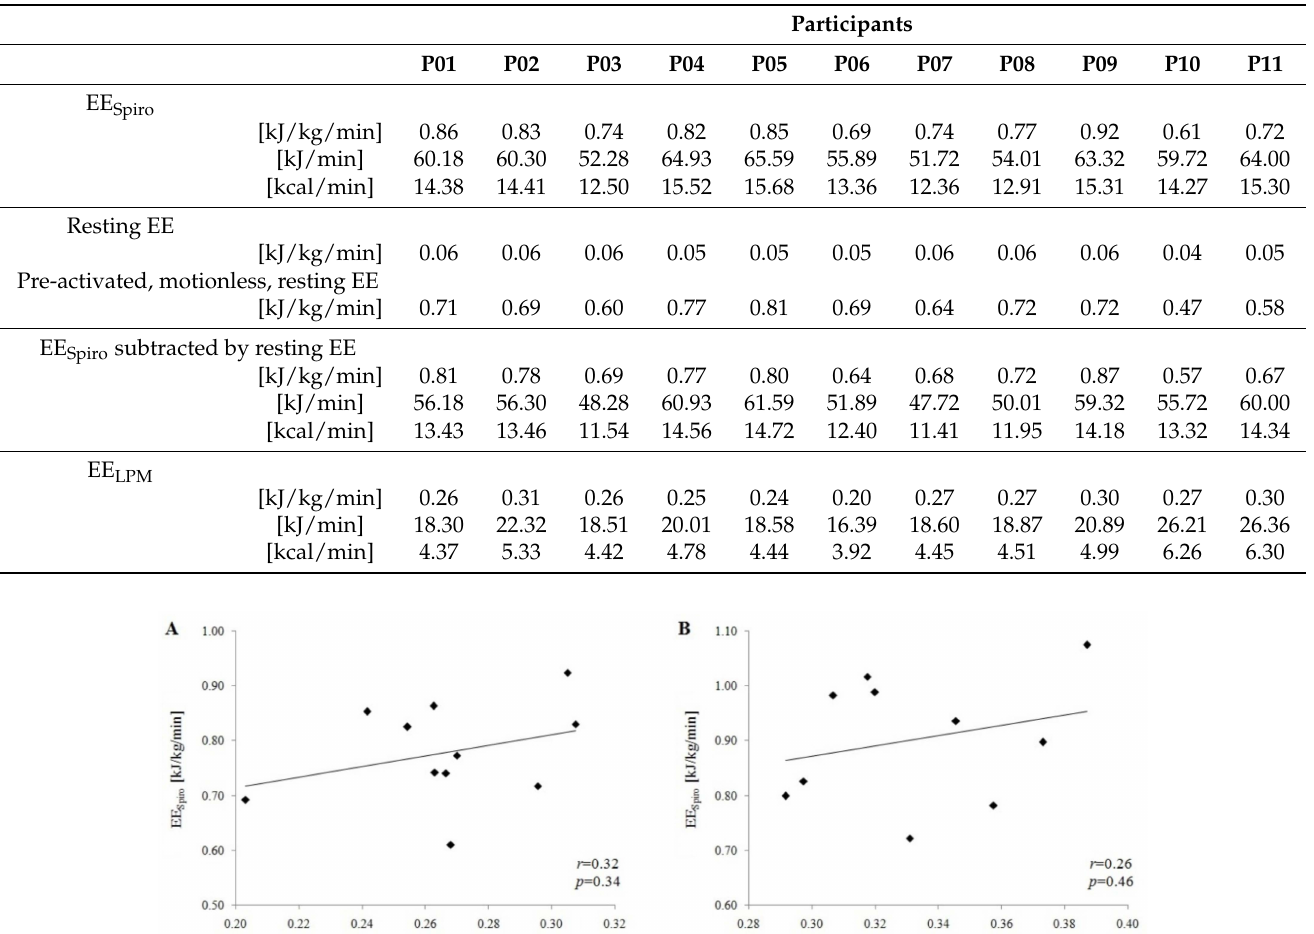
Table 1. Energy expenditure (EE) via spiroergometry (EE Spiro ) and local position measurement (EE LPM ) during the entire GBPT.